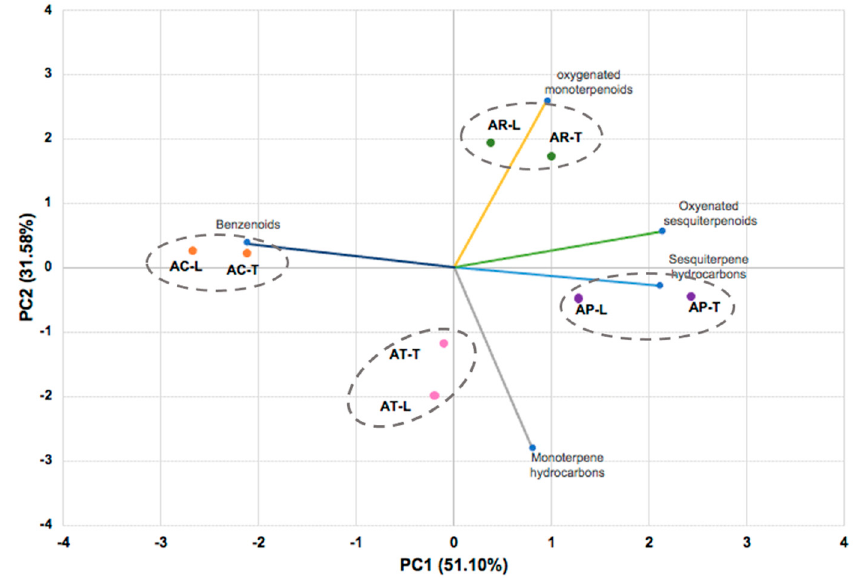
Figure 1. The bidimensional plot of the first two components from principal component analysis (PCA) of Aniba species, based on the classes of compounds present in their essential oils: AC ( A. canelilla ), AP ( A. parviflora ), AR ( A. rosaeodora ), AT ( A. terminalis ), L (leaves), T (twigs), PC1 (first principal component), PC2 (second principal component).